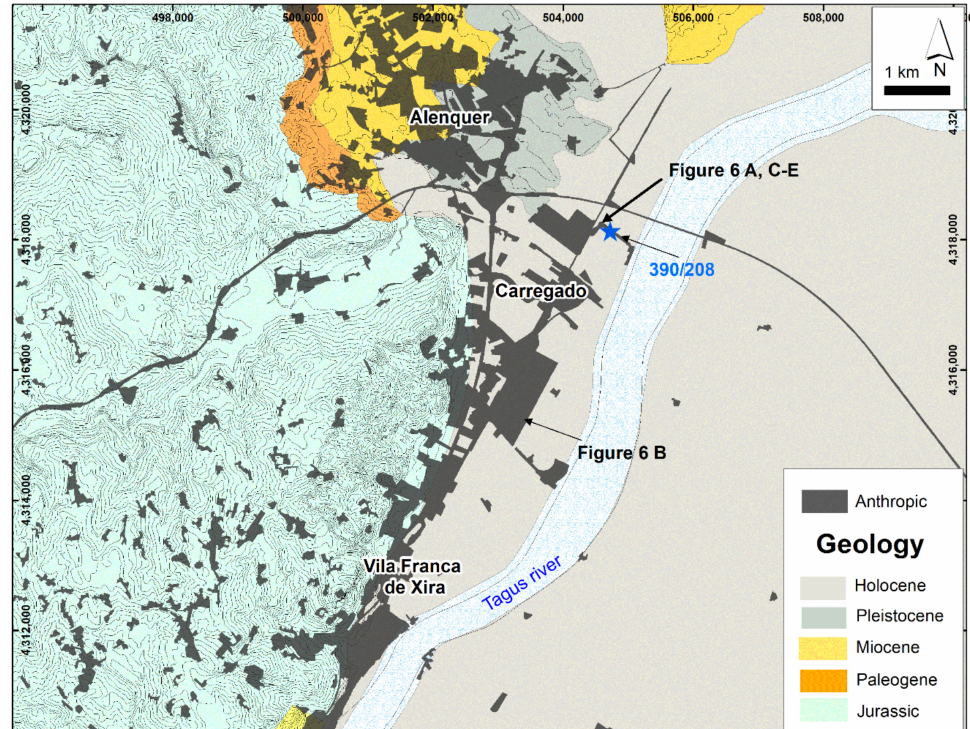
Figure 5. Geological settings of local study area. See location of evidence observed in field campaigns in October and November 2021. Blue star and code 390/208 represent location of water